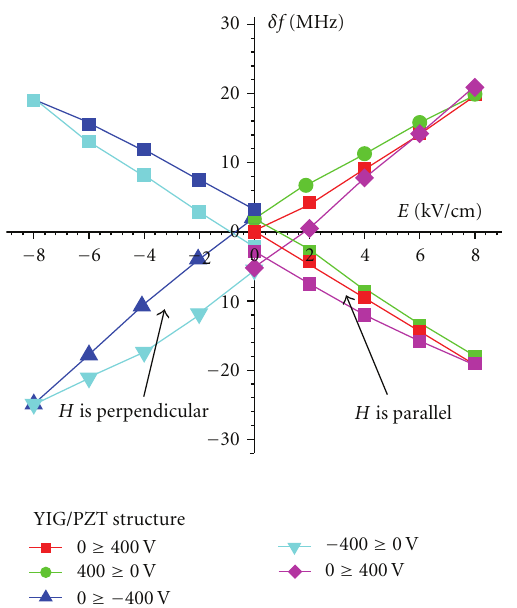
Figure 7: The dependence of the frequency shifts δ f versus intensity of E in case that magnetic field is parallel and perpendicular to the plane of